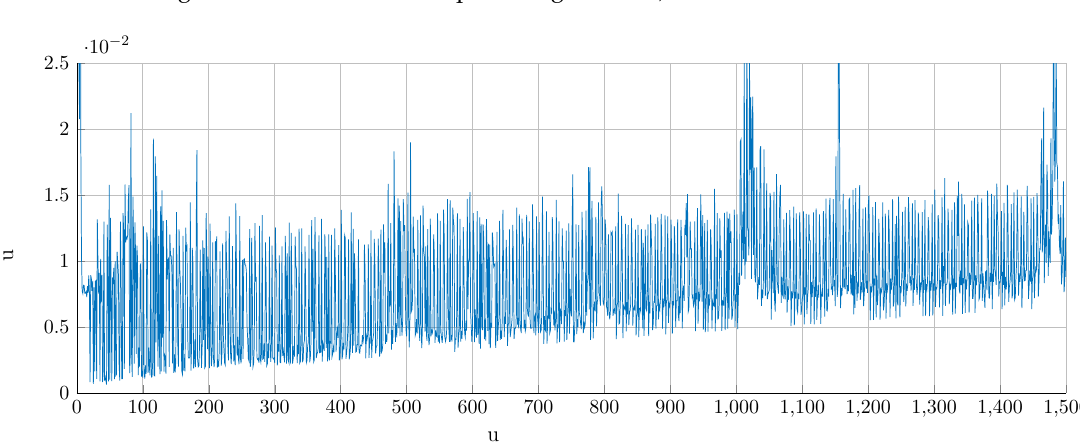
Figure 6. Evolution of the computation time versus the number of iterations (case s = 3, r =